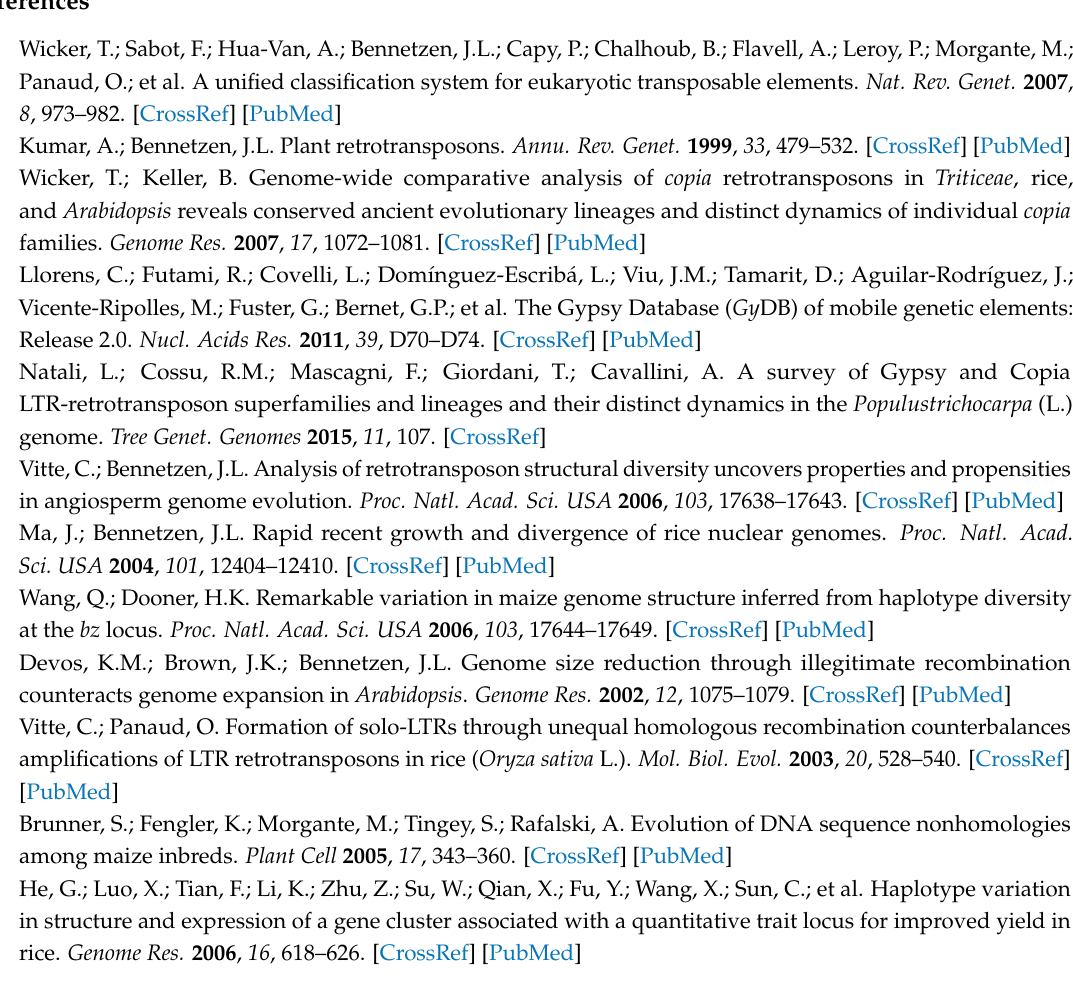
Table S1: Number of mapped reads per million reads of 22 LTR-RE families in eightdomesticated genotypes and seven wild accessions, Table S2: Number of gene-RE mapping paired reads per million reads of 22 LTR-RE families in eight domesticated genotypes and seven wild accessions, Table S3: List of genes mapped by gene-RE paired Illumina reads of domesticated (a) and wild (b)